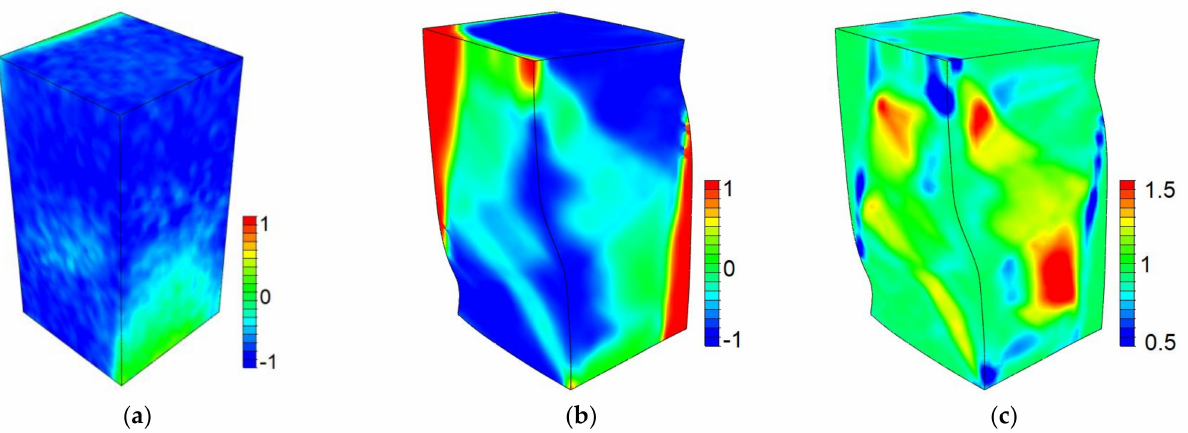
Figure 11. Normalized stress fields in the single crystal with the {100} faces under compression along the [001] axis: σ yy at strains of 0.005 ( a ) and 0.05 ( b ) and von Mises stress at a strain of 0.05 ( c ).